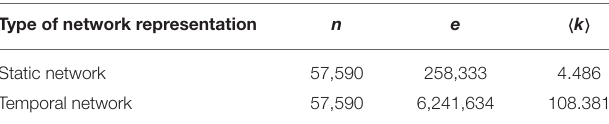
TABLE 1 | Basic statistical features of the pig trade network, including the number of nodes n , the number of edges e , and the average degree h k i . Type of network representation n e h k i Static network 57,590 Temporal